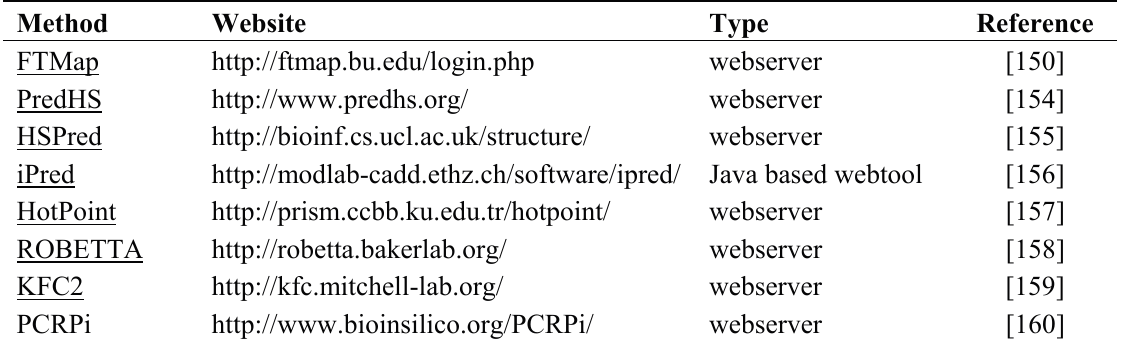
Table 4. A list of software tools and servers available for identification of hot